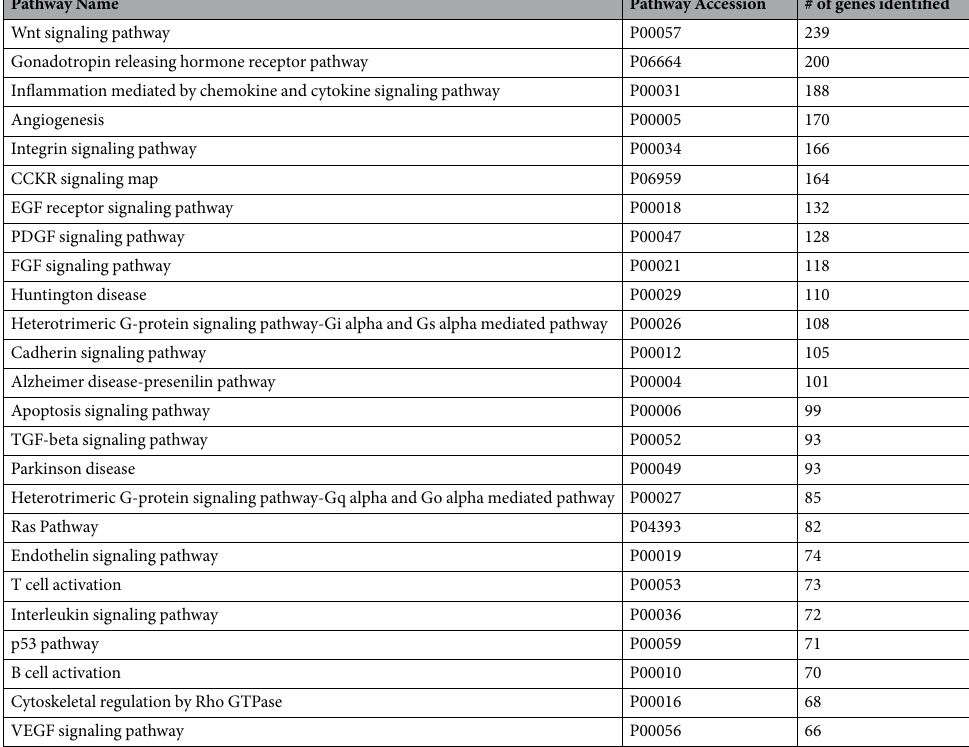
Table 1. Top 25 assigned pathway ontologies for assembled Carassius auratus RGC genes based on the number of genes identified in each